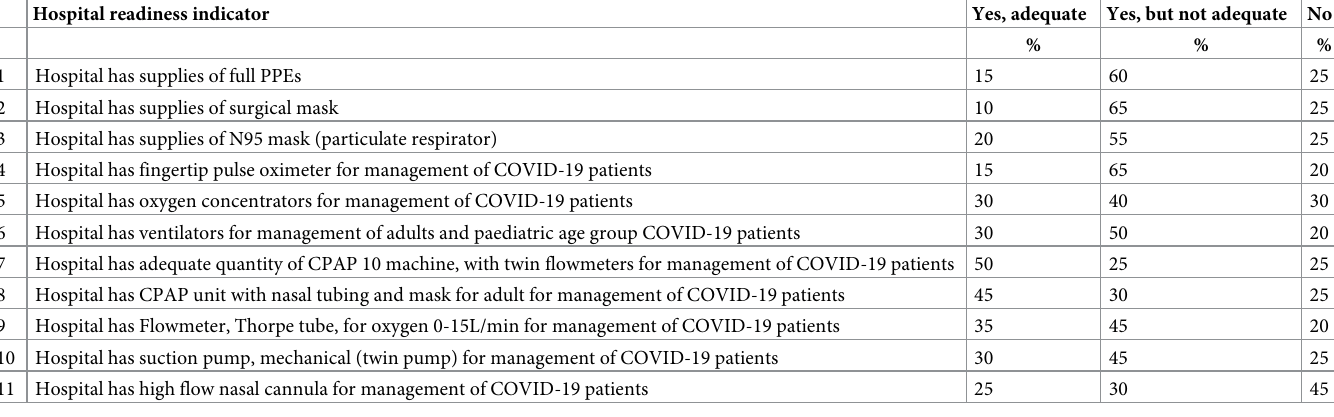
Table 11. Availability of critical items for COVID-19 response among 20 hospitals in